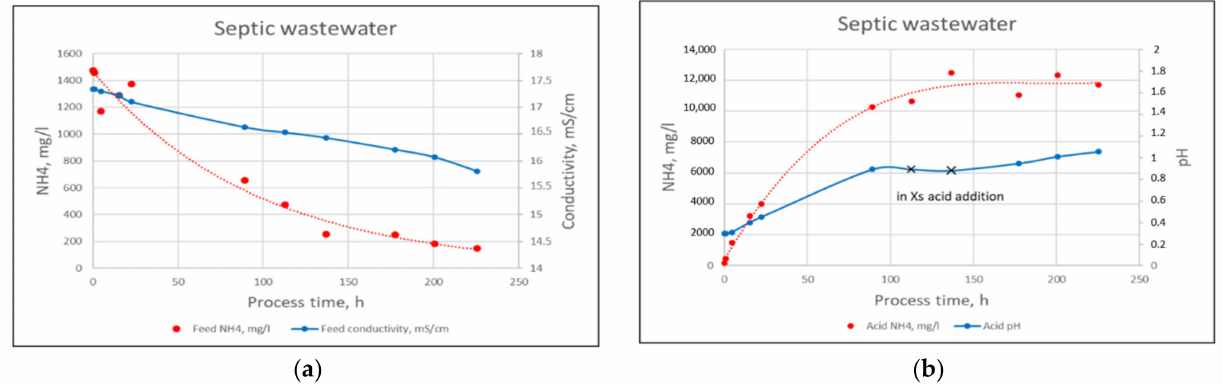
Figure 11. Conductivity and ammonia content of feed solution ( a ) and pH and ammonia content of acid solution ( b ) during a 225-h membrane contactor process with septic